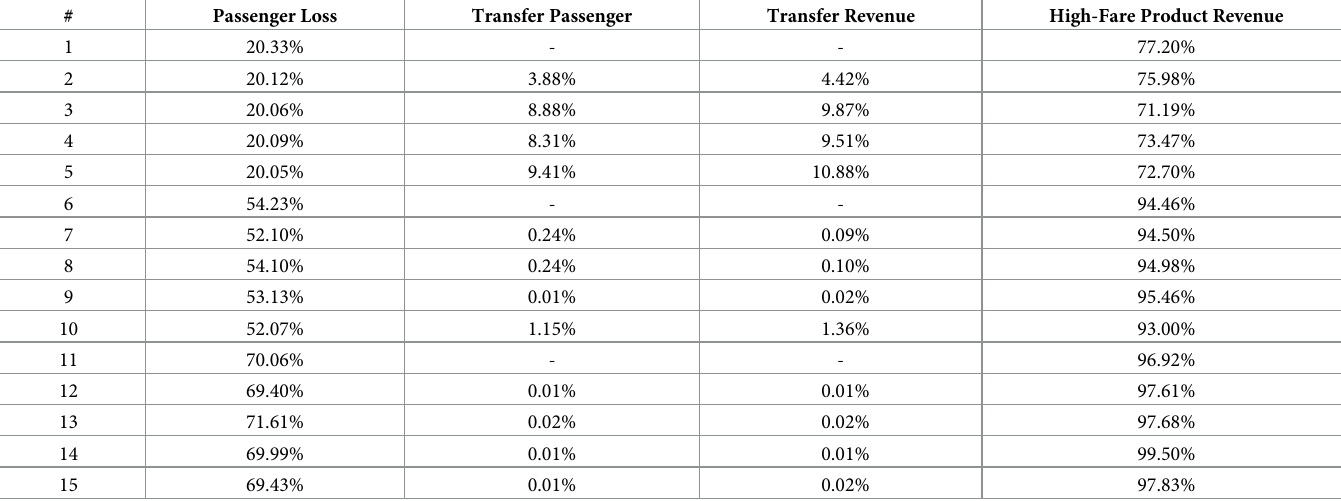
Table 13. Four indicators from ticket selling